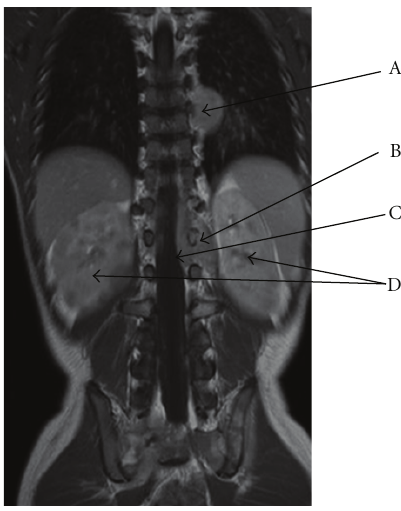
Figure 3: MRI (coronal T1 gadolinium): left dorsal paravertebral tumor (T7–T9) (A) and left dorso-lumbar paravertebral mass (B) with epidural compression (C) through infiltration via interverte- bral foraminae (T12–L2). Bilateral nodular nephromegaly (D).